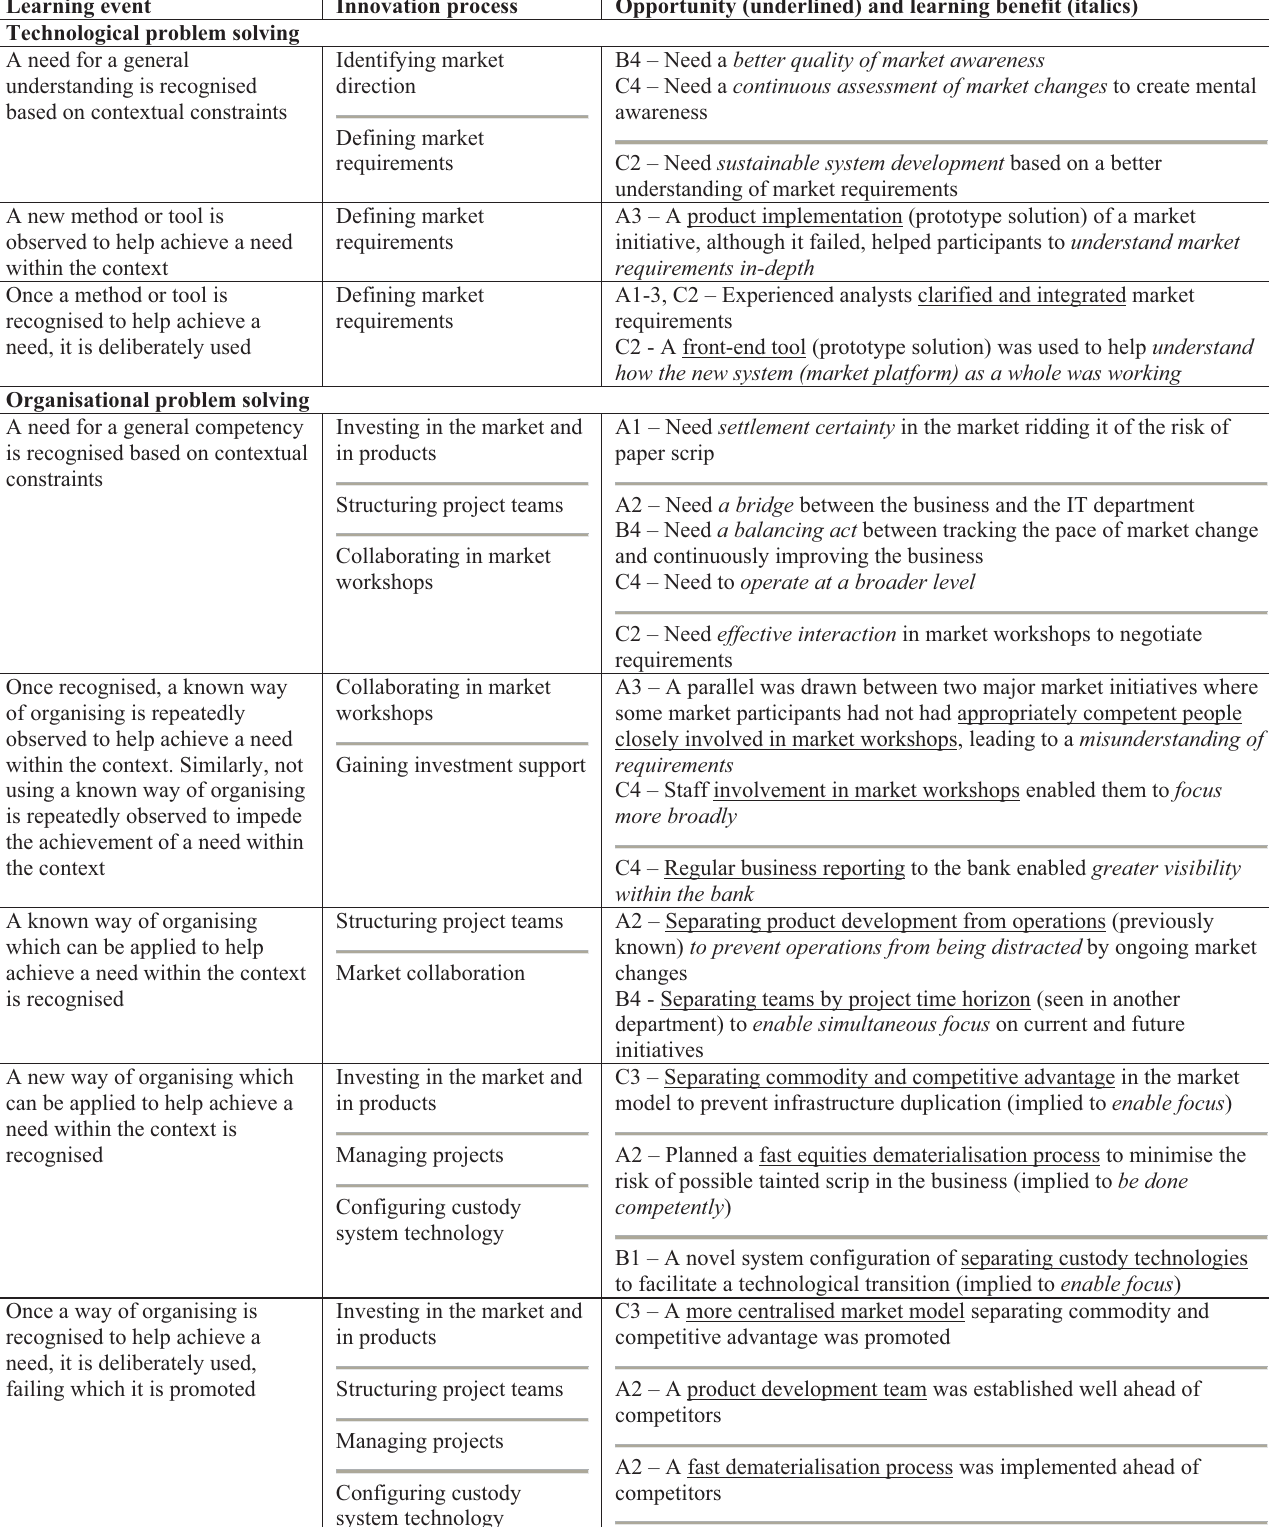
Table 3: Entrepreneurial learning pattern Learning event Innovation